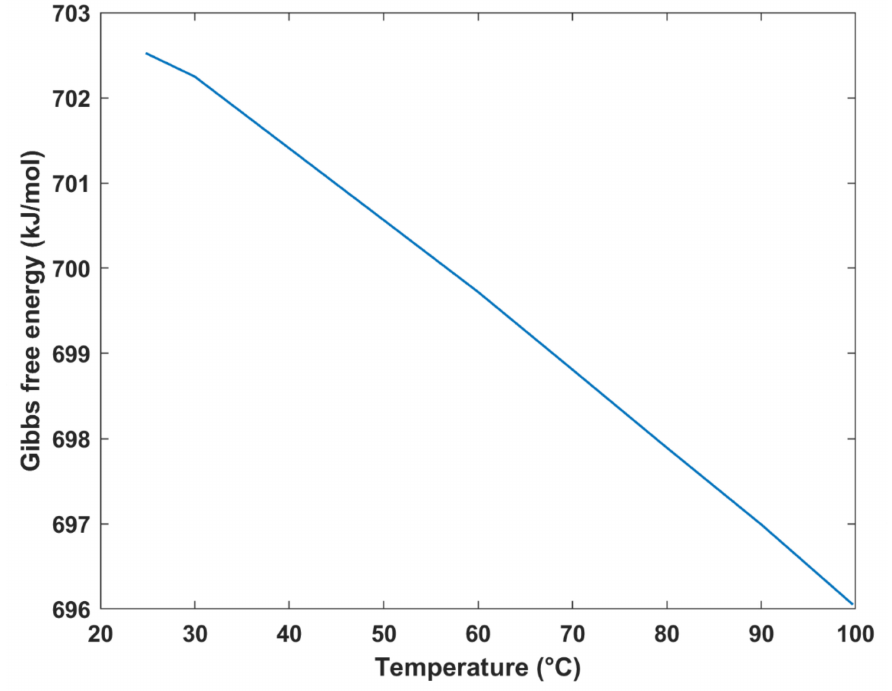
Figure 8. Gibbs free energy vs.